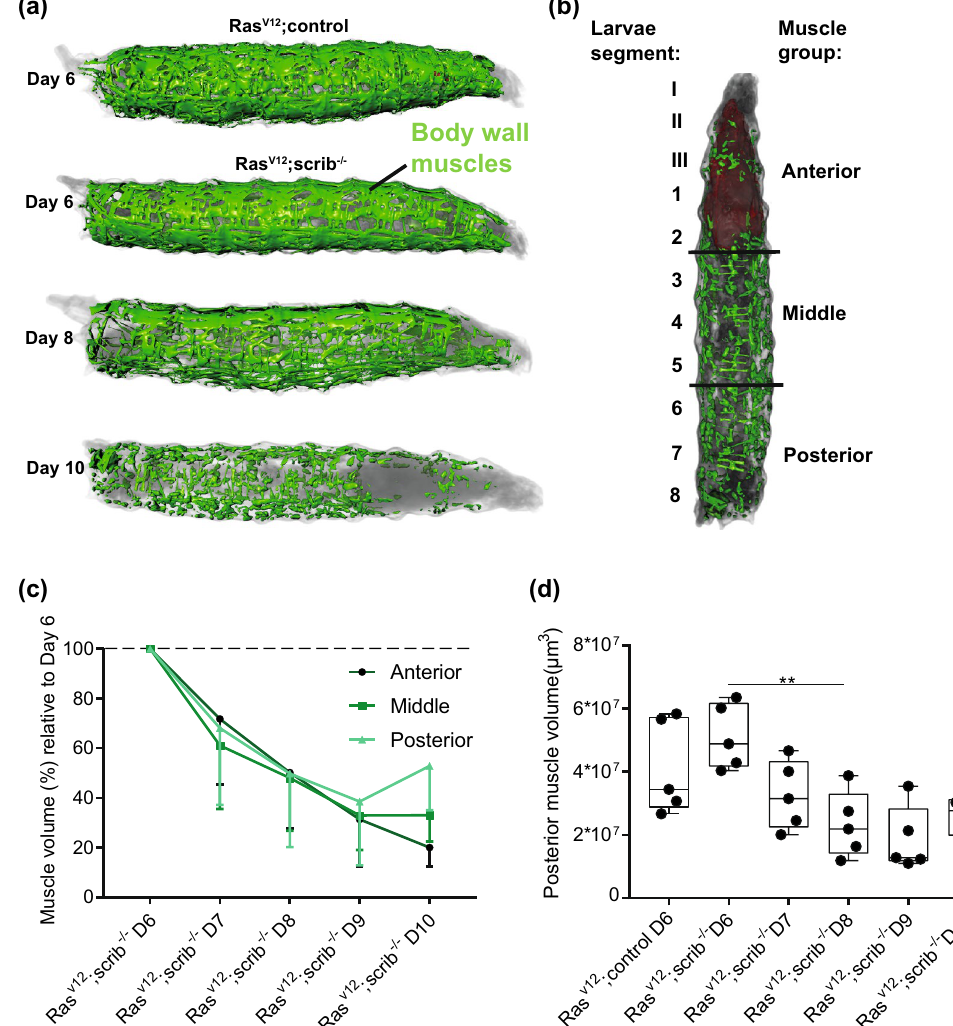
Figure 2. Posterior muscle volumes are strongly reduced from day 6 to day 8 of tumor development. ( a ) Illustration of body-wall muscles in a control larvae or with a tumor at several time-points. ( b ) Illustration of how we divide the larval muscles into groups to analyze how muscle position relative to the tumor affects the muscles. The tumor is growing in the anterior of the animals. ( c ) Summed volumes of the different muscle groups, shown relative to the day 6 measurement to illustrate how the muscle volumes change in different parts of the animal due to the anterior tumor. ( d ) Posterior muscle volumes shown for all time-points. The indicated statistical test is one-way ANOVA with a Turkeys’s multiple comparisons test. **p < 0.01. Shown images are of representative larvae. Quantifications in ( c ) and ( d ) are of n = 5 individual